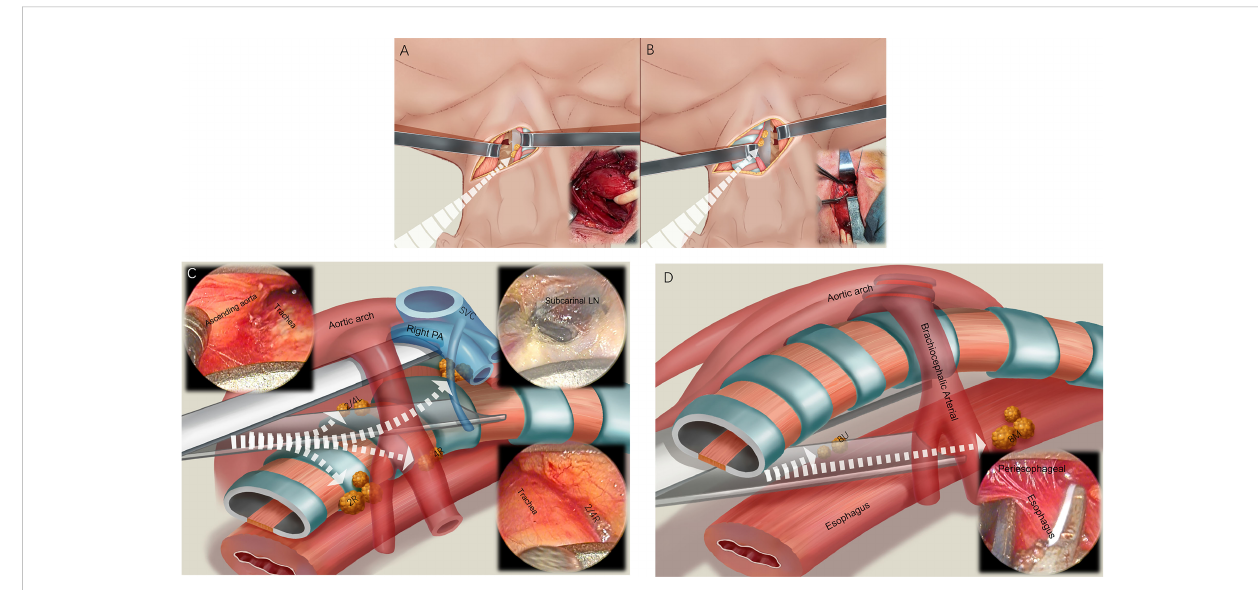
FIGURE 3 Four channel lymphadenectomy. After the 5-cm arc neck incision is made, the fi rst channel is entered to dissect the left paraesophageal lymph nodes and 1L lymph nodes (A) . Then, the second channel is used to dissect the right paraesophageal lymph nodes and 1R lymph nodes (B) . The pretracheal space (third channel) is then entered, and the 2R, 4R, 7, 2L, and 4L lymph nodes are dissected (C) . Finally, we enter around the esophagus (fourth channel), dissect the 8U and 8M lymph nodes, and free the esophagus (D)